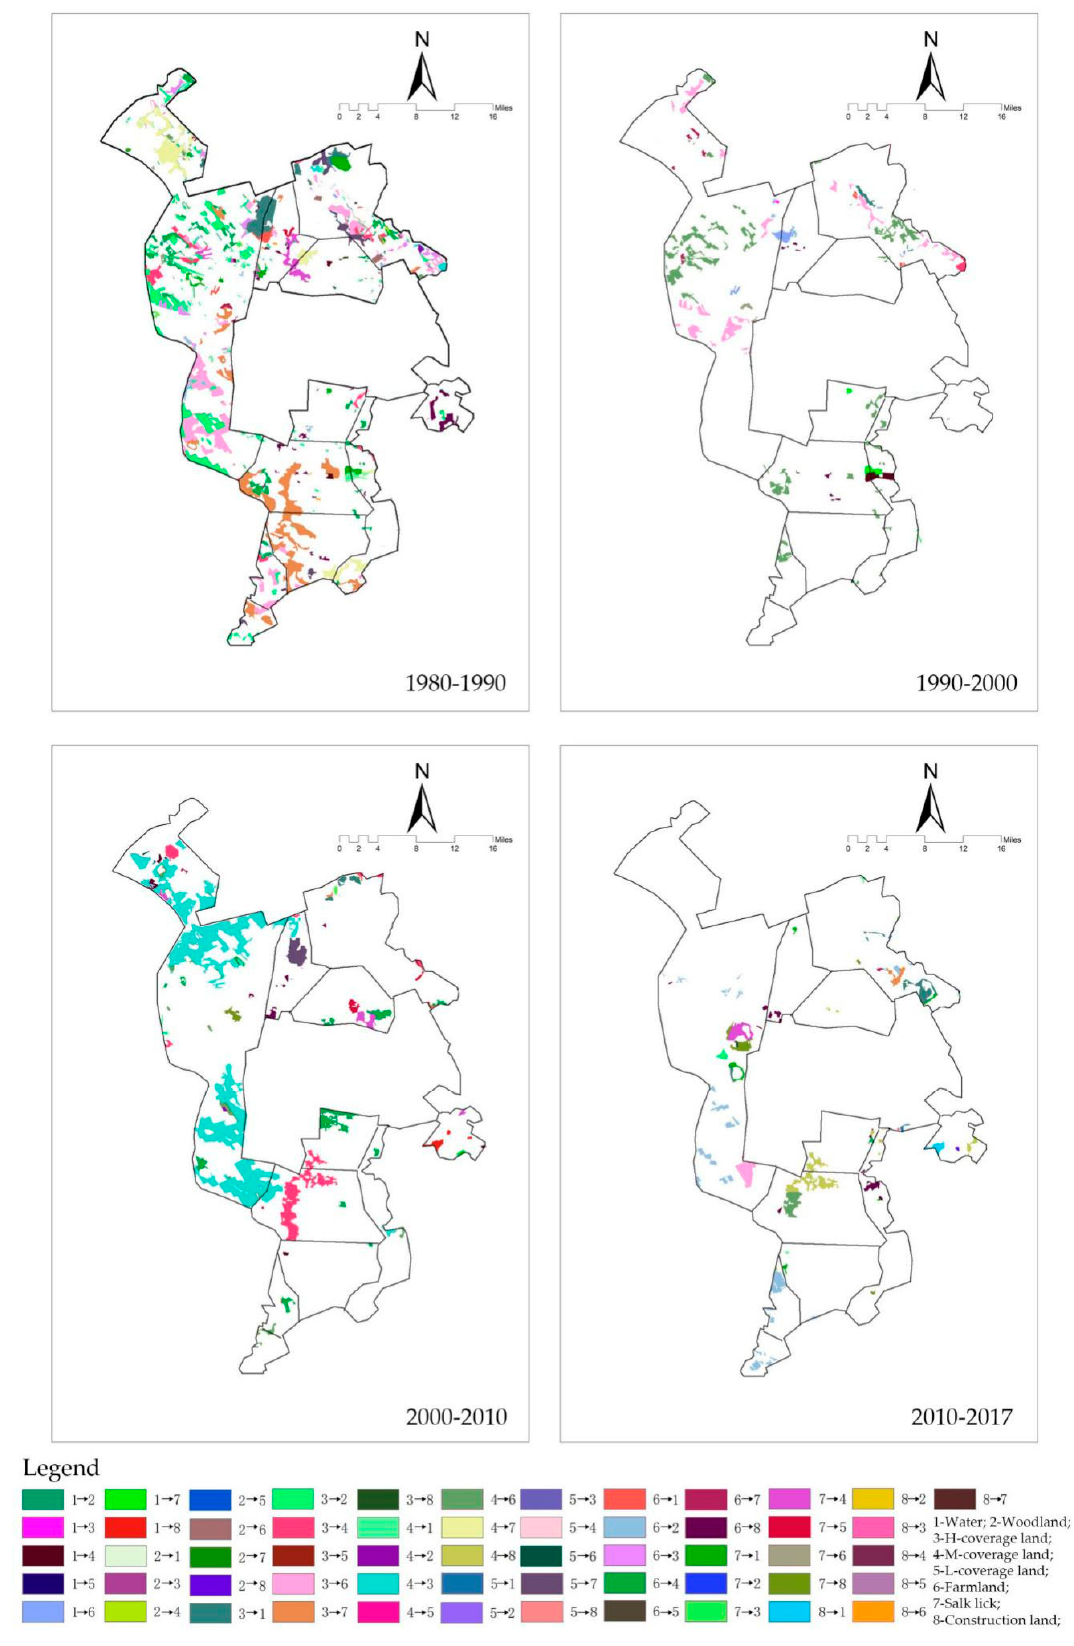
Figure 16. Distribution of land use transfer.